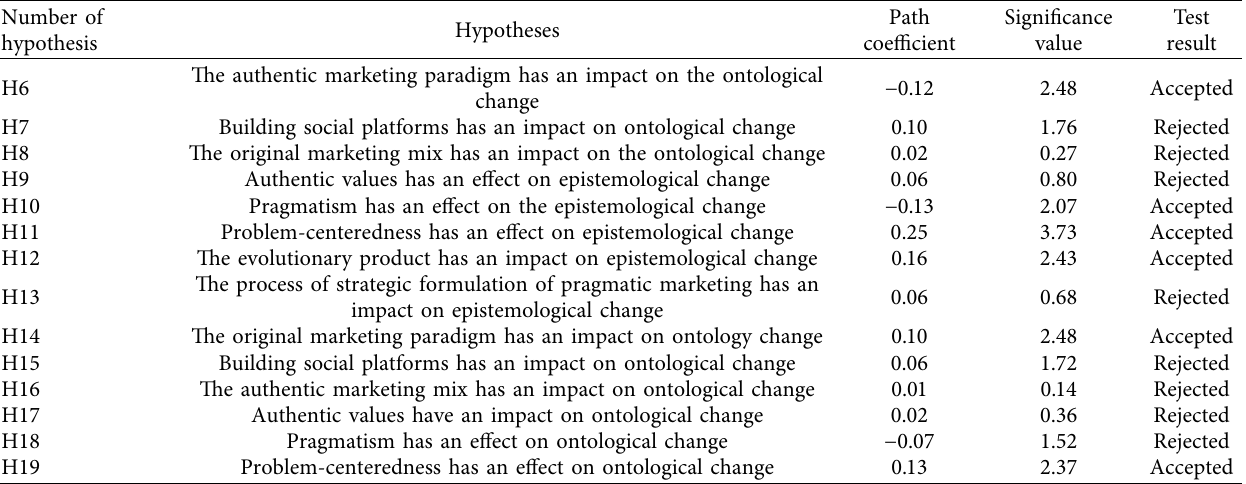
Table 8: Partial least squares analysis results for second-order research